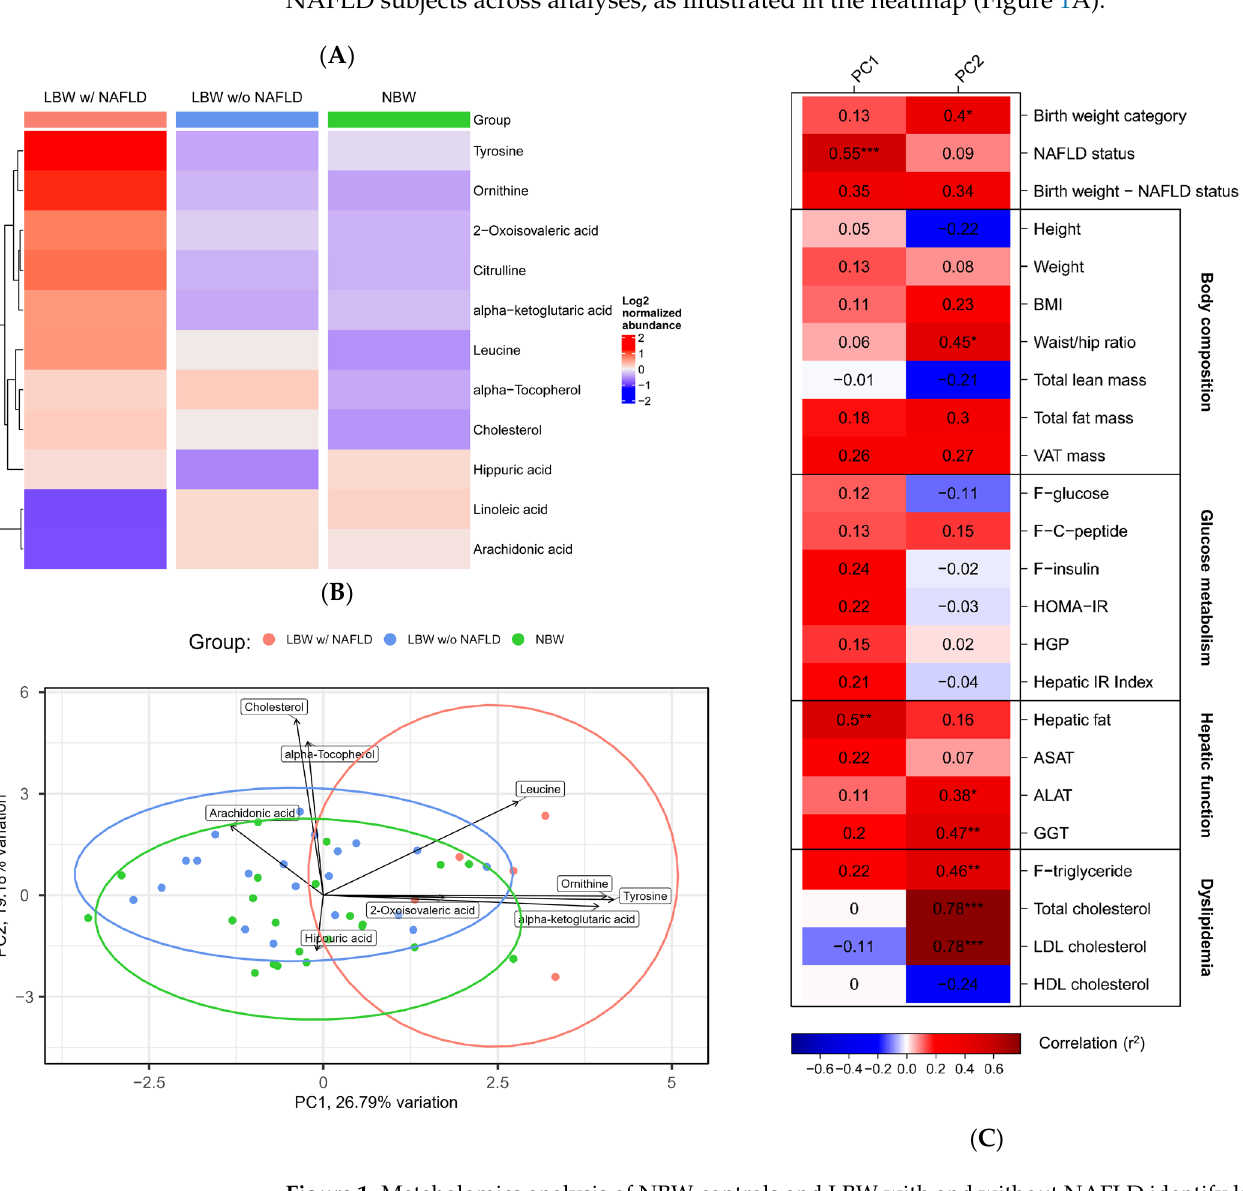
Figure 1. Metabolomics analysis of NBW controls and LBW with and without NAFLD identify key metabolites differentiating the 3 groups ( n = 22, n = 21 and n = 5, respectively). ( A ) Heatmap of the log2 normalized abundances of the 11 distinct serum metabolites in the LBW w/NAFLD, LBW w/o NAFLD and NBW groups. Red color indicates increased abundance, blue color indicates decreased abundance. ( B ) PCA plot based on the 11 distinct metabolites. Each dot represents an individual. PC1 and PC2 explained ~46% of the total variance (PC1 = 26.79% and PC2 = 19.18%). The ellipses illustrate the 95% confidence interval. Metabolites with loadings above 0.1 (negative or positive) are labeled. ( C ) An Eigencor plot illustrating correlations between panels of clinical variables associated with a specific metabolic trait and PC1 and PC2 from the PCA (Pearson, r 2 > 0.38), * (P FDR ≤ 0.1), ** (P FDR ≤ 0.01), and *** (P FDR ≤ 0.001). Red color indicates positive correlation, blue color indicates negative correlation.